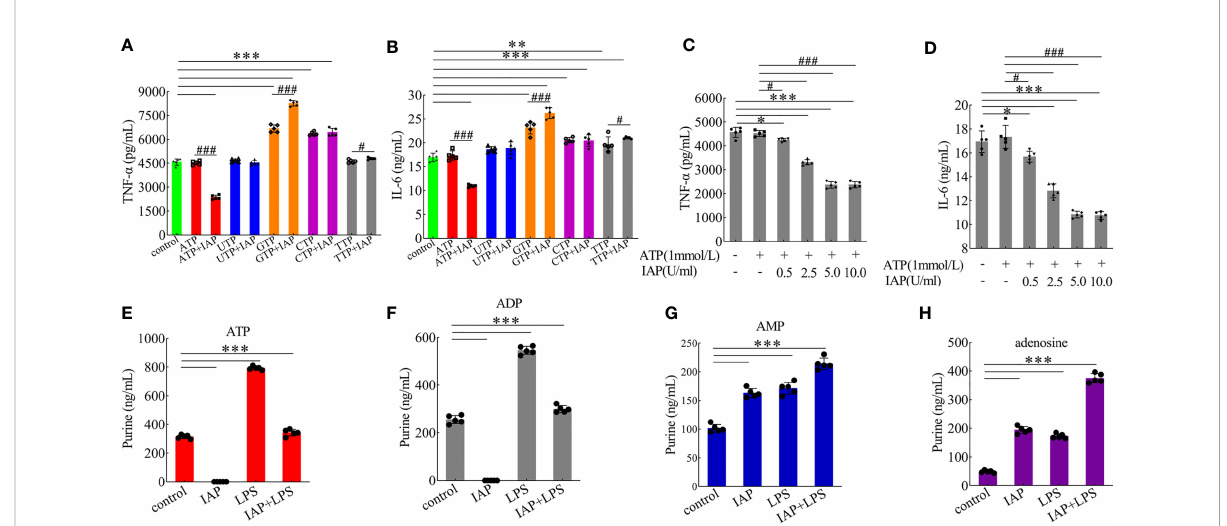
FIGURE 8 Anti-in fl ammatory effect of IAP on dephosphorylation of nucleoside triphosphate. The effect of IAP on the secretion of (A) TNF- a and (B) IL-6 by dephosphorylation of nucleoside triphosphate. The effect of different IAP activity on ATP dephosphorylation on the secretion of (C) TNF- a and (D) IL-6. The effect of IAP and LPS on (E) ATP, (F) ADP, (G) AMP, and (H) adenosine release in cocultured HT-29 cells + freshly extracted human leucocytes. Values are presented as means ± SD (n = 5 wells/group). Two-tailed unpaired Student ’ s t test. For multiple comparisons, analysis of variance with Tukey was used. (A, B) compared with control, *P < 0.05, **P < 0.01,***P < 0.001; compared with the nucleoside triphosphate group, # P < 0.05, ### P < 0.001. (E – H) ***P <